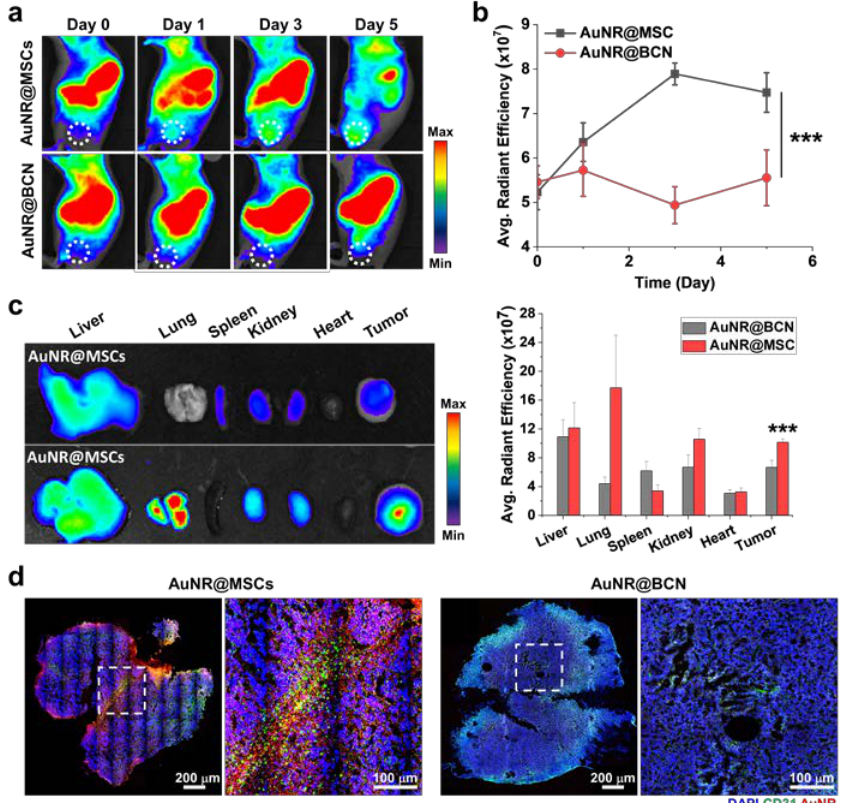
Figure 4. Deep tumor penetration of AuNR@MSCs in colon tumor models. ( a ) NIRF images of HT29 tumor-bearing mice after AuNR@MSCs or AuNR@BCN treatment. ( b ) Fluorescence intensities in the tumor tissues of HT29 tumor-bearing mice after AuNR@MSCs or AuNR@BCN treatment. ( c ) Ex vivo fluorescence images of major organs after 5 days of AuNR@MSCs or AuNR@BCN treatment. ( d ) Tumor tissues stained with fluorescent dye-conjugated anti-CD31 antibody after 5 days of AuNR@MSCs or AuNR@BCN treatment. Statistical significance is indicated with asterisks (*** p < 0.001)